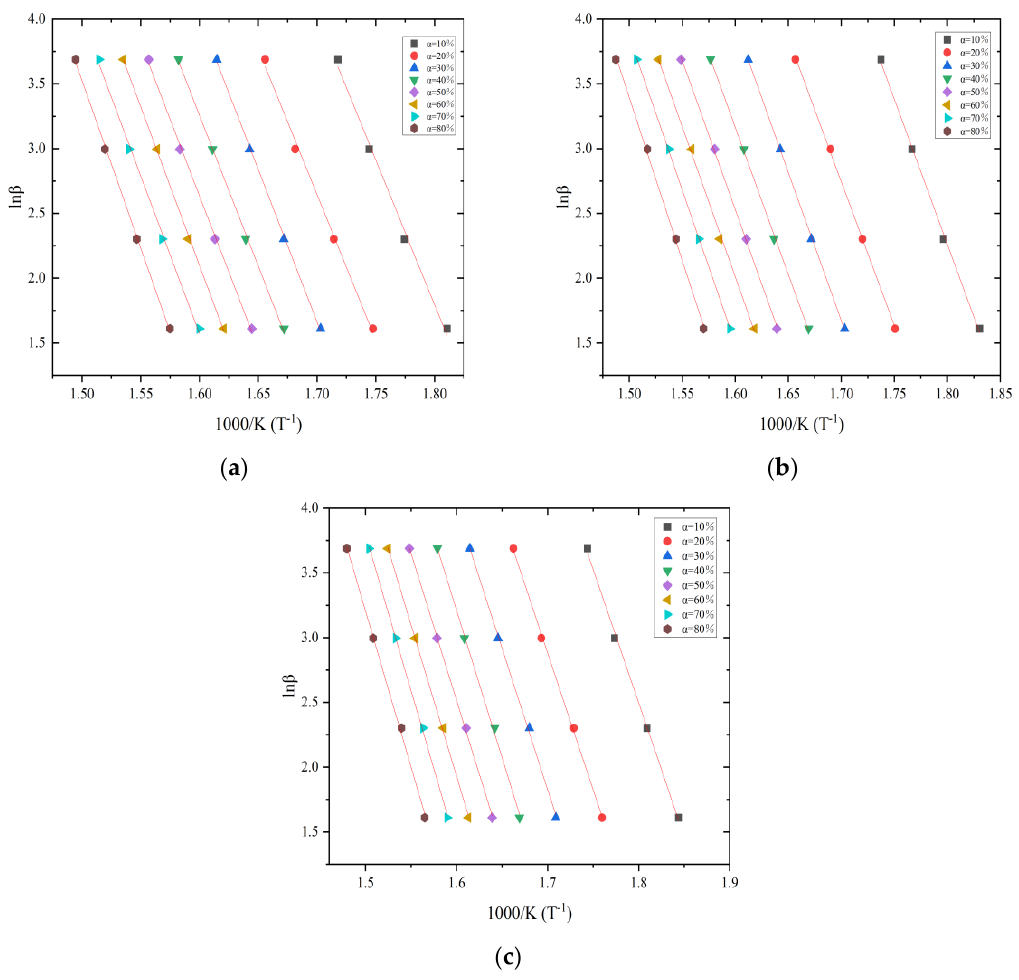
Figure 6. FWO linear regression at different conversion rates: ( a ) natural aging − 10; ( b ) natural aging − 70; ( c ) natural aging − 100.